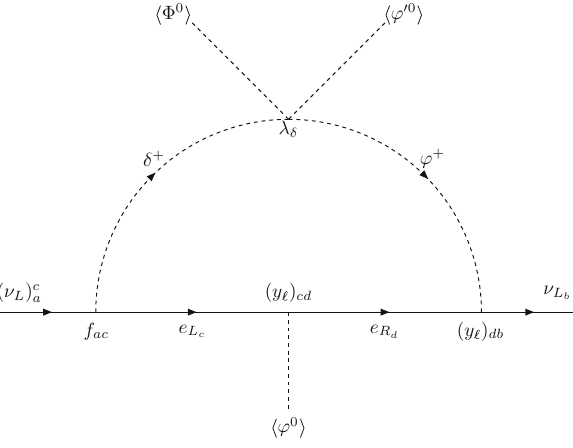
Fig. 1 One loop correction to active neutrino masses N ( d ) bases N L = V † L